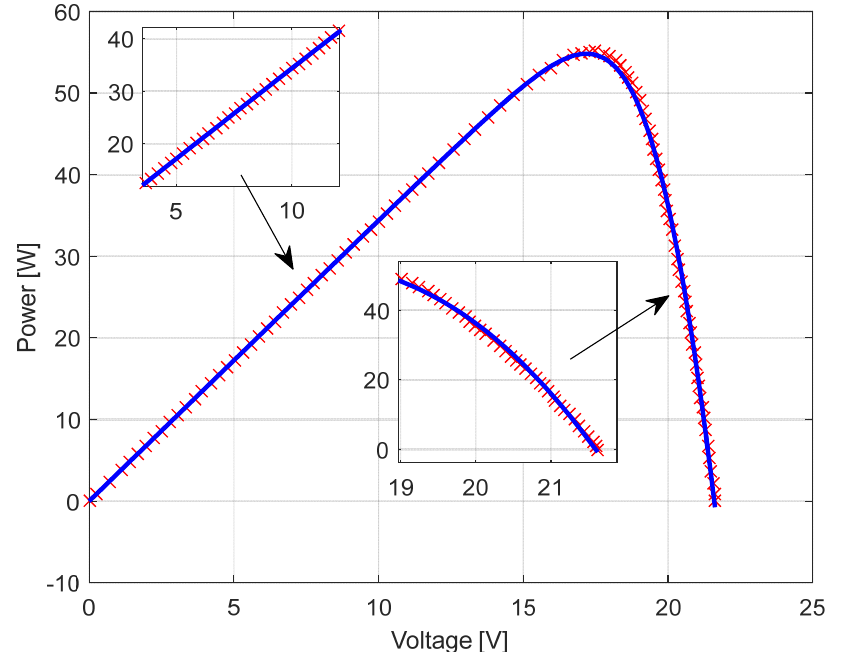
Figure 15. Power-voltage characteristics at 1000 W/m 2 and 25 °C.